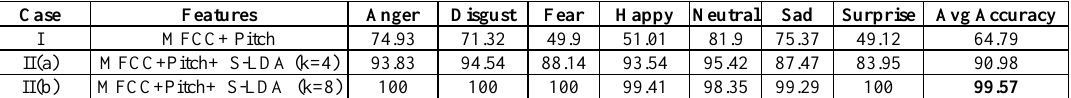
Table 3. AER for SAVEE database using 1D-CNN